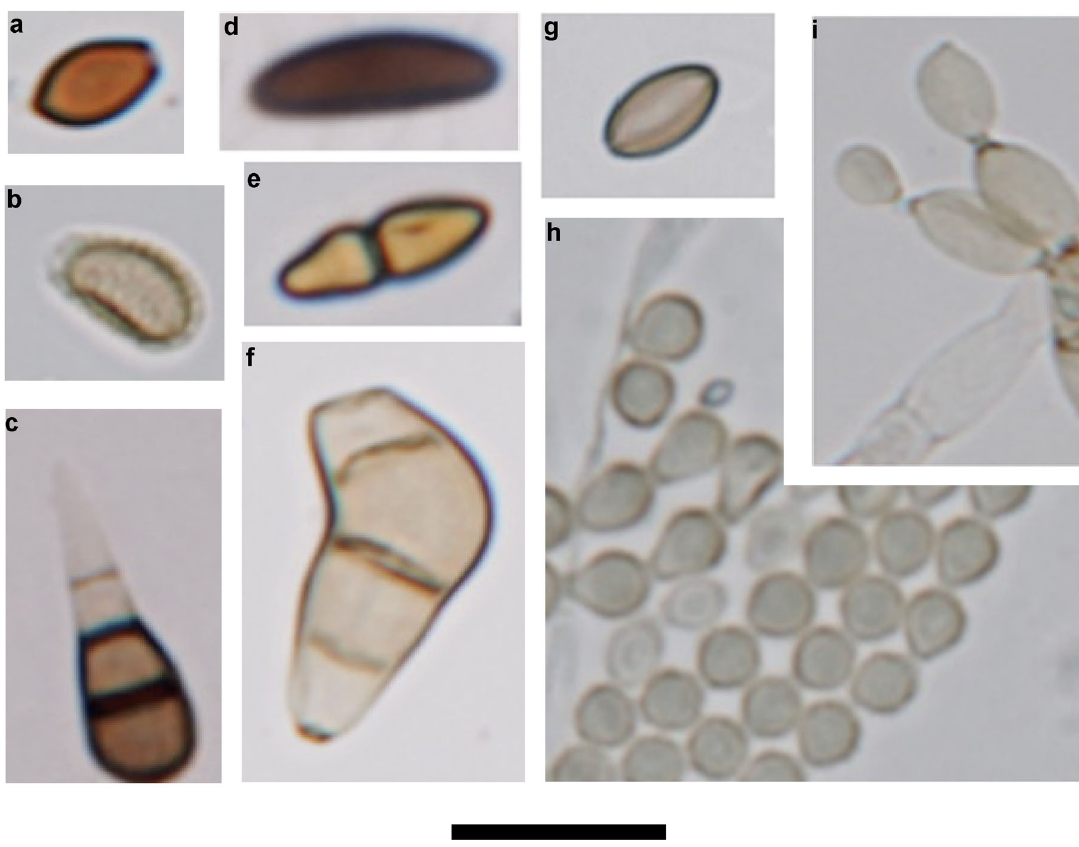
Fig. 2 Images of common fungal spores sampled at the different heights over the rainforest and identi fi ed up to family level. a Agaricaceae, b Poliporaceae, c Pleosporaceae, d Xylariaceae, e Venturiaceae, f Pleosporaceae, g Agaricaceae, h Trichocomaceae, i Cladosporiaceae. Scale bar: 10